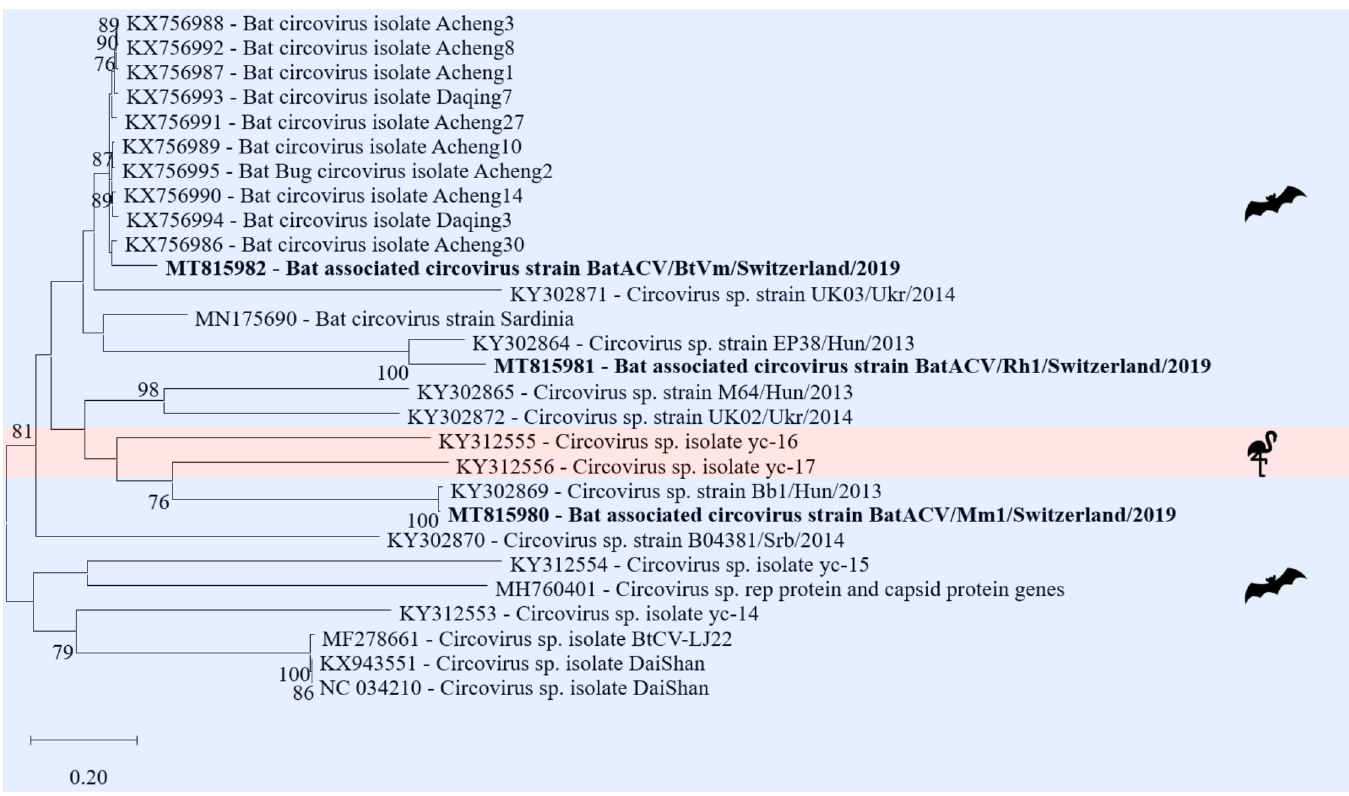
Fig 10. Phylogenetic analysis of the full genome of circoviruses. The sequences obtained in this study (GenBank acc. numbers MT815980-82) are shown in bold. Sequences of non-bat associated viruses are marked with a red background and those of bat associated viruses with a blue background. The pictograms on the right side represent the species in which the virus was detected. Sequences were aligned using Muscle. For phylogenetic analysis, the Maximum likelihood tree with 1’000 bootstraps was used. Only values � 70% are displayed.